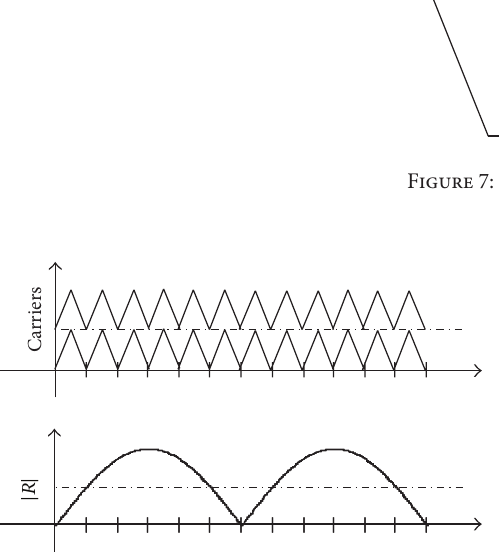
Figure 8: Waveforms of the PWM controller.